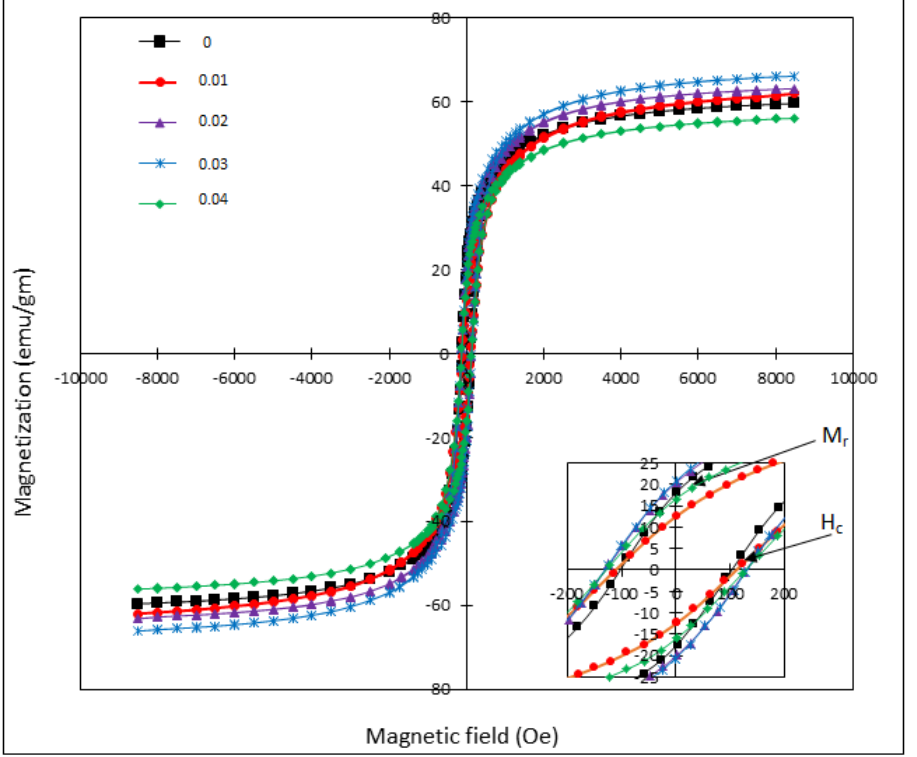
Fig.10: Magnetic hysteresis loops of Ni